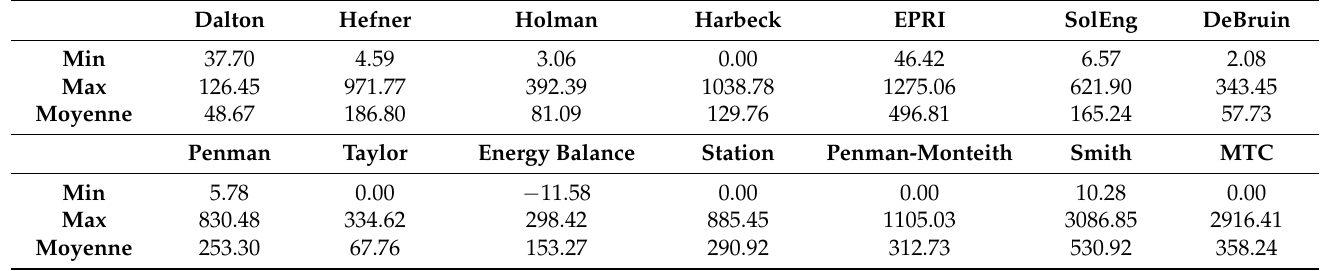
Table 2. Statistical characteristics of the evaporation energy calculated using different methods.